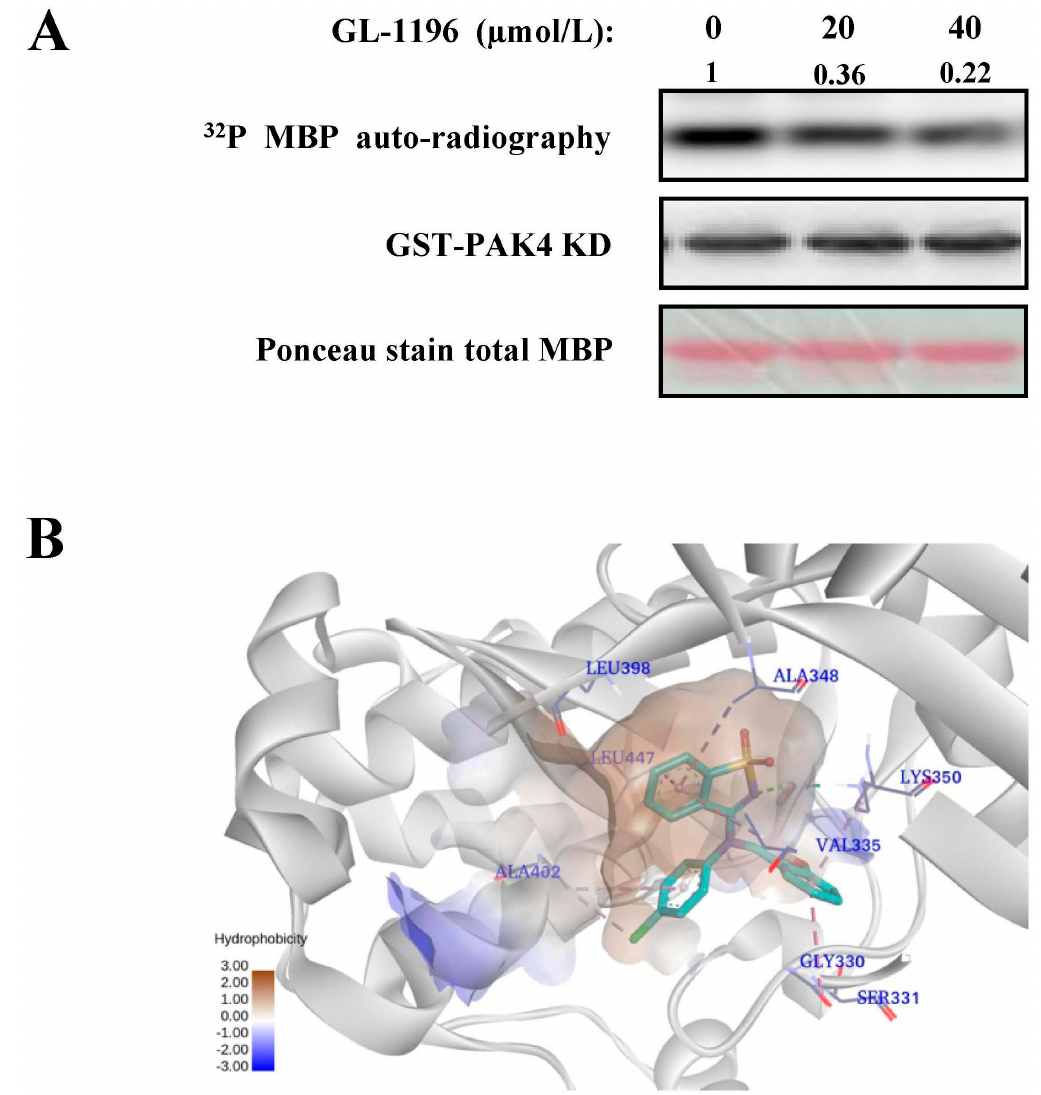
Figure 4. GL-1196 inhibits PAK4 kinase activity. ( A ) the effect of GL-1196 on PAK4 kinase activity was detected by kinase assay; ( B ) the binding mode of GL-1196 within PAK4 binding site. The green structure indicates the chemical structure of GL-1196.